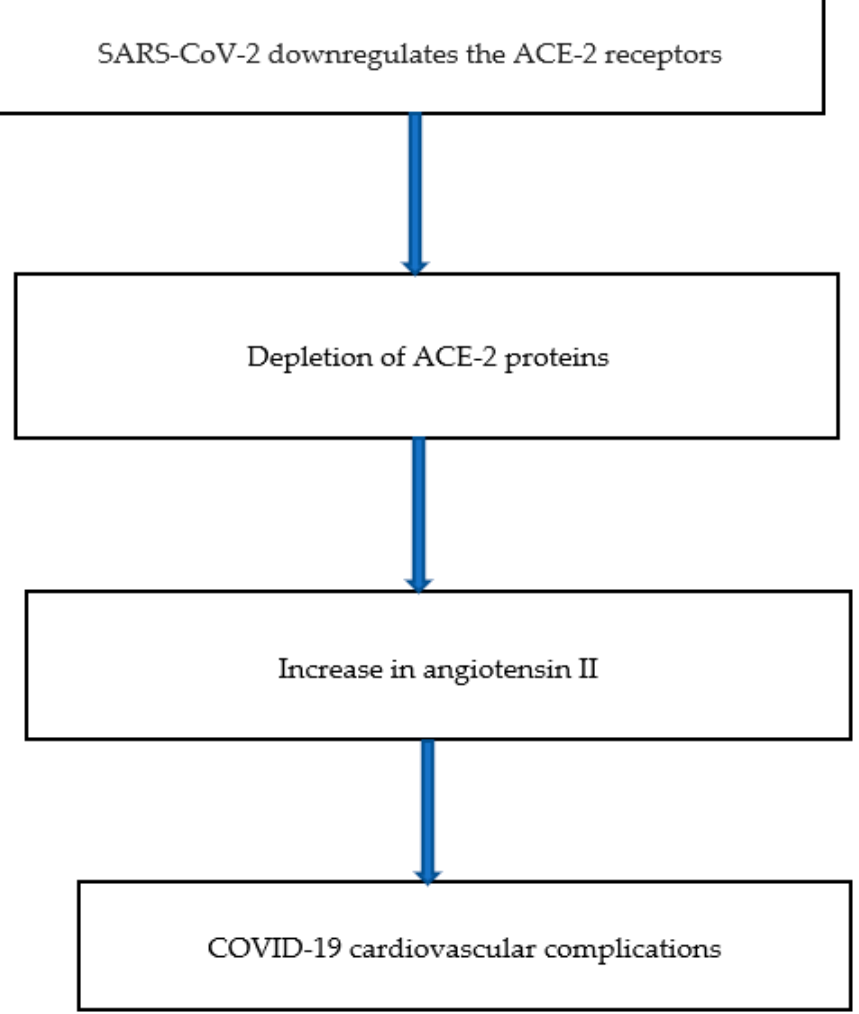
Figure 2. Diagrammatic illustration ofACE-2 inhibitors downregulation mechanism.